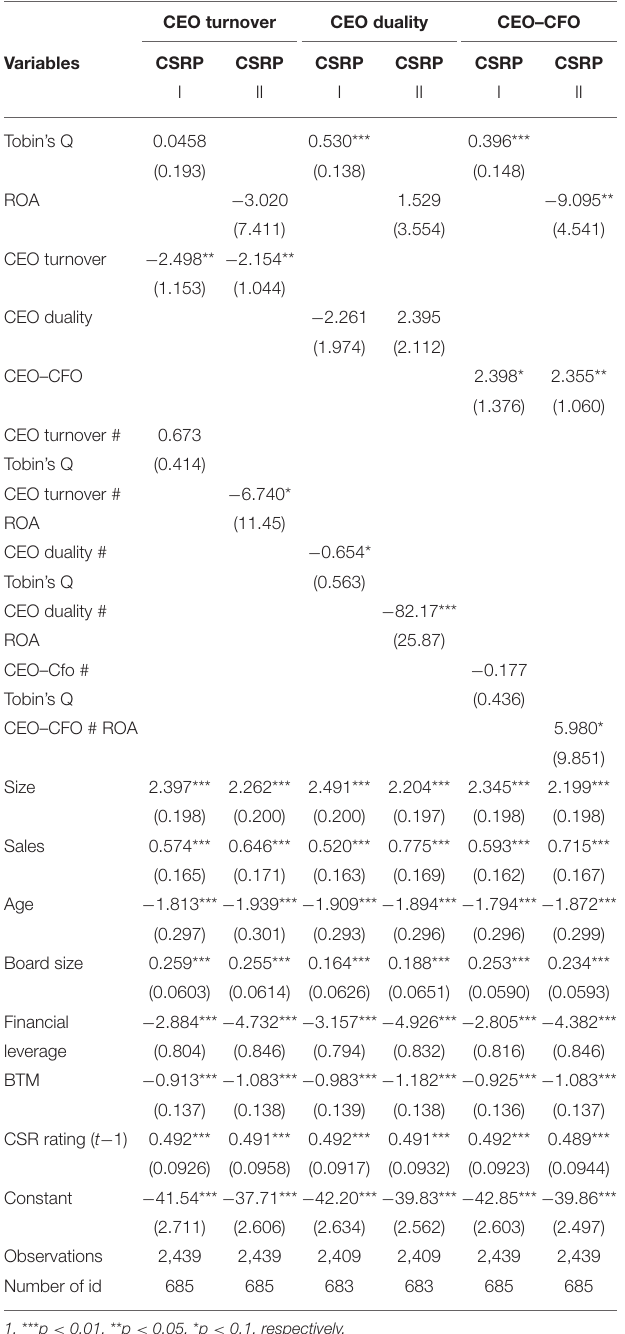
TABLE 5 | Moderating effect of CEO role in CSRP–CFP Nexus (sysGMM parameter